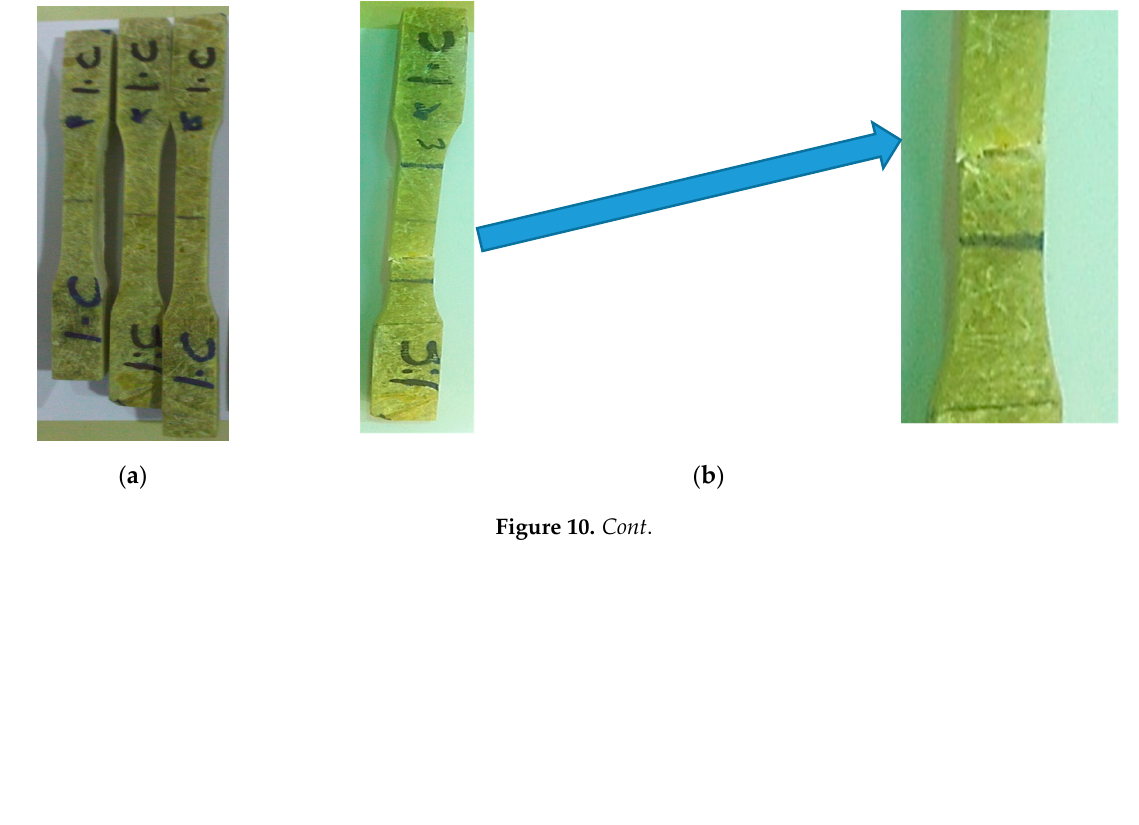
Figure 9. ( a ) Prepared specimens machined along the axial direction; ( b ) Failed specimen showing matrix cracking, fiber debonding, and huge delamination between the straight pipe and the overwrapped composite; ( c ) Stress–strain curve of axial specimens.